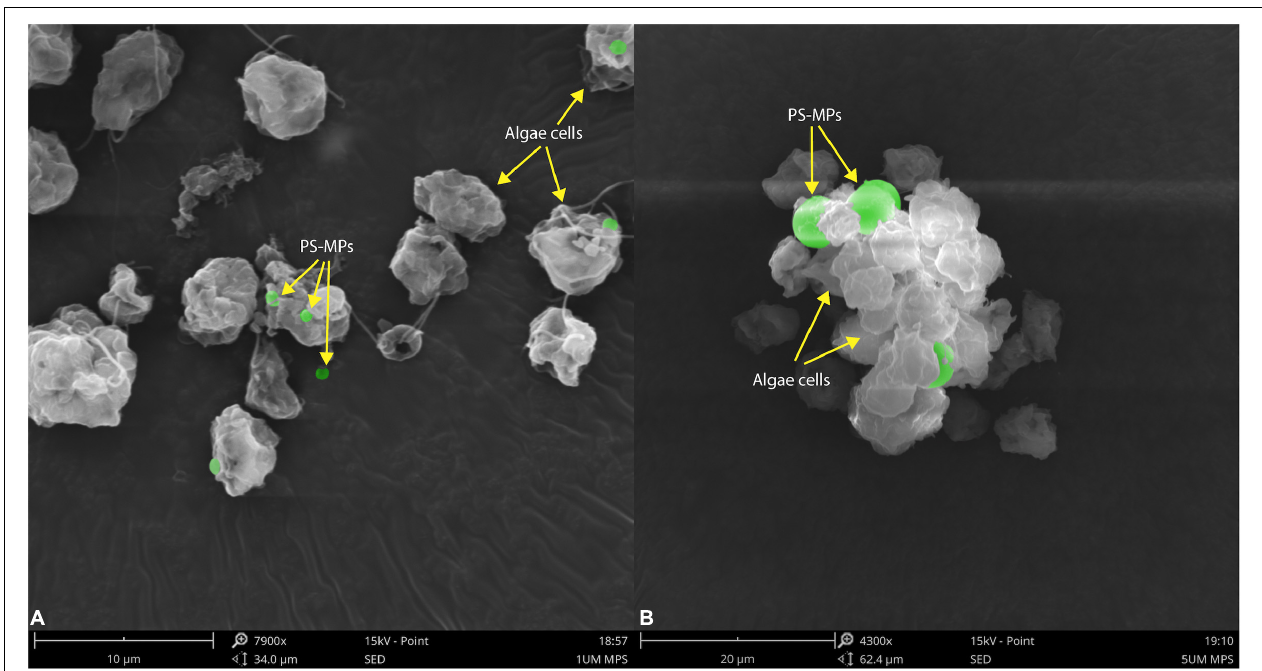
FIGURE 3 | Scanning electron microscopic images of C. reinhardtii exposed to different particle size of PS-MPs (A) 1 µ m MPs; (B) 5 µ m MPs. The identified MPs are green colored.